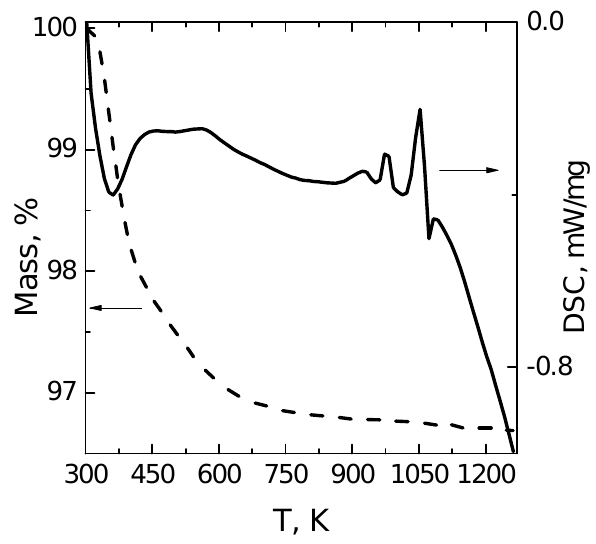
Figure 3. TG-DSC curves of the 8 t sample. XRD analysis (Figure 4) of the as-synthesized material demonstrates the peaks from the perovskite PMN-0.3PT [01-088-1864] structure and small-intensity peaks from MgO [30-0794]. After high-temperature treatment, the intensity of the perovskite peaks gradually decreases. Additional reflections appear in the XRD spectra of samples treated at 1073 and 1273 K. These peaks are identified as pyrochlore Pb 2 Ti 2 O 6 [26-142] cubic phase. Since both PMN-0.3PT and PBC are stable in the studied temperature range [29,40], the formation of pyrochlore phase is associated with the interaction between PBC and PMN-0.3PT at 900–1100 K (see Figure 3).